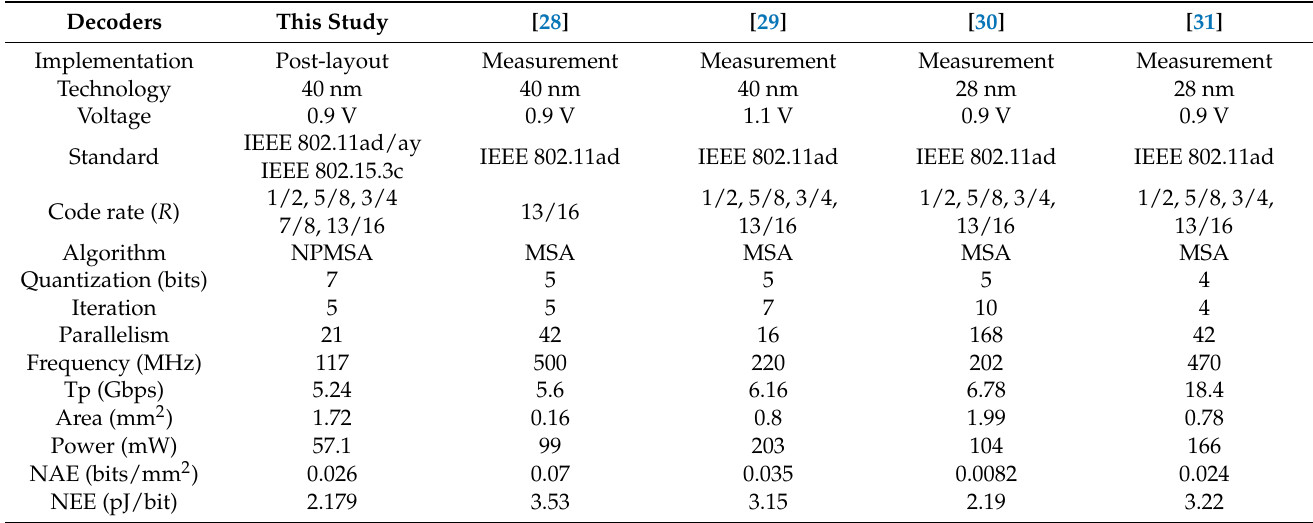
Table 4. Chip comparisons among different LDPC decoders for IEEE 802.11ad standard.